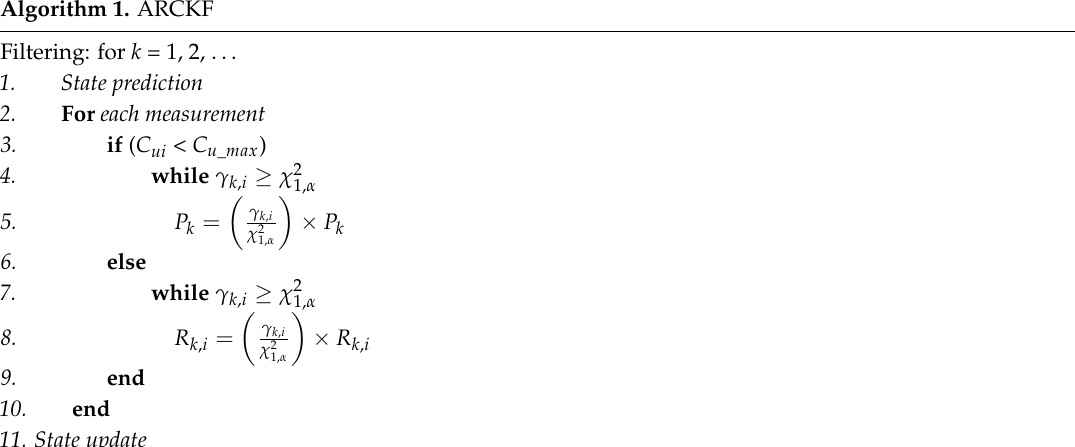
Figure 7. UWB tag and IMU. Table 1. Key specifications of the IMU. Instrument